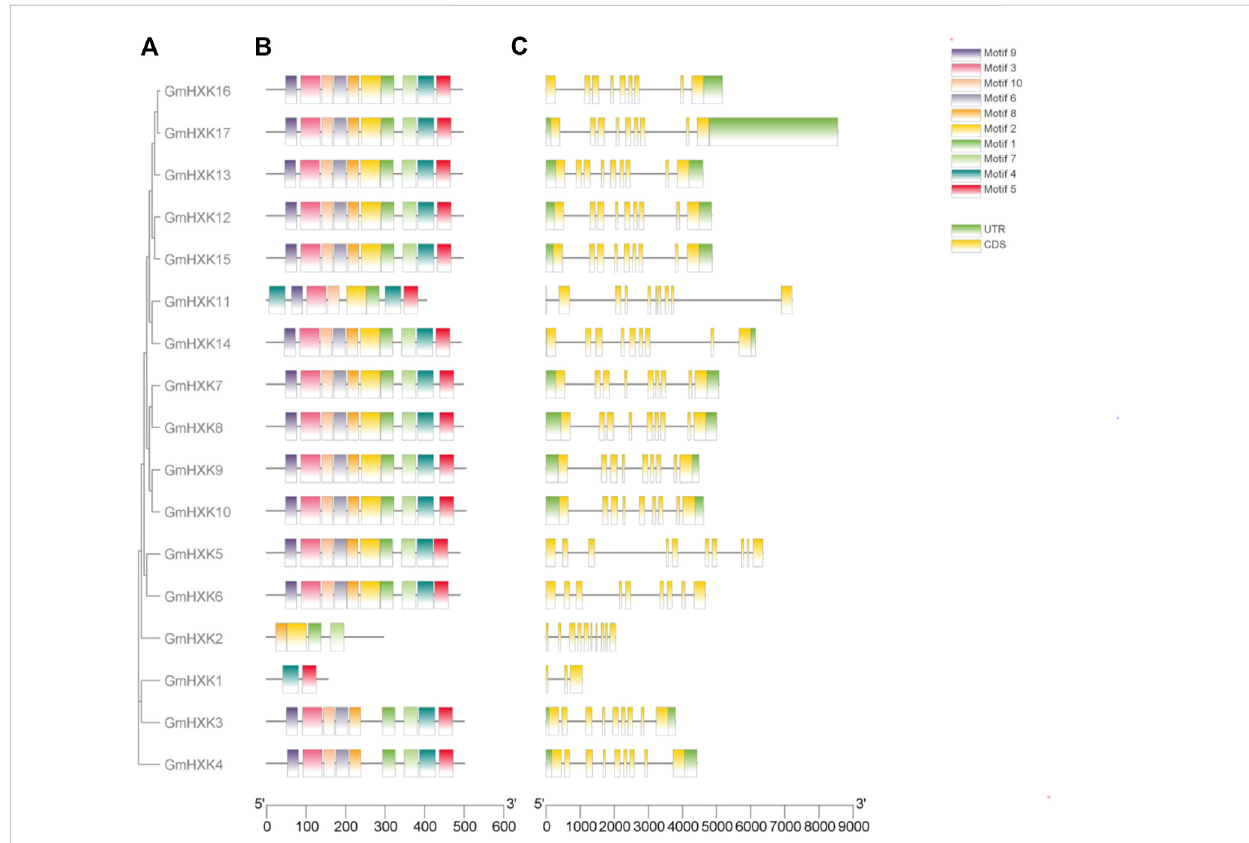
FIGURE 3 The conserved domain organization and exon-intron structure of GmHXKs genes. (A) . Phylogenetic relationships of GmHXK genes. The GmHXK amino acid sequences were aligned by Clustal X and the tree was generated using the Neighbor-Joining method in MEGA-X with 1,000